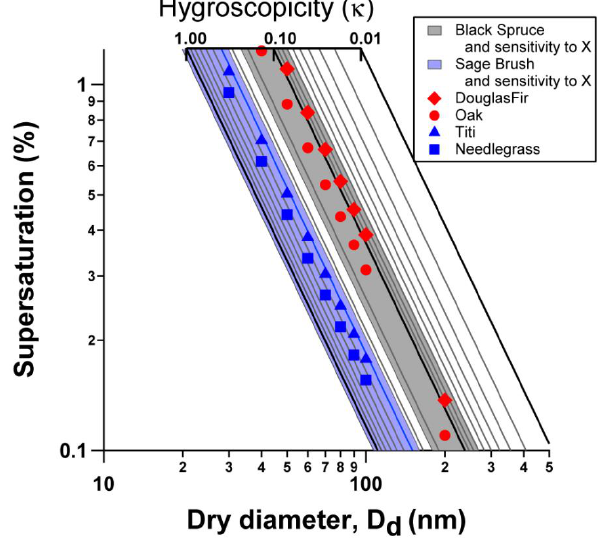
Figure 8: Sensitivity analysis of κ to χ. κ data for each biomass burning species is taken from 803 Figure 8. Sensitivity analysis of κ to χ . κ data for each biomass burning species is taken from Petters et al. (2009). The sensitivity Petters et al. 2009. The sensitivity of κ to χ is analyzed using two constant dynamic shape 804 of κ to χ is analyzed using two constant dynamic shape factors of factors of 1 to 1.5. The region between the two χ values is shaded in grey for black spruce 805 1–1.5. The region between the two χ values is shaded in grey for and blue for sage brush. The κ lines for Douglas fir, oak, titi, and needlegrass rush are 806 black spruce and blue for sage brush. The κ lines for Douglas fir, shown for comparison. 807 oak, titi, and needlegrass rush are shown for